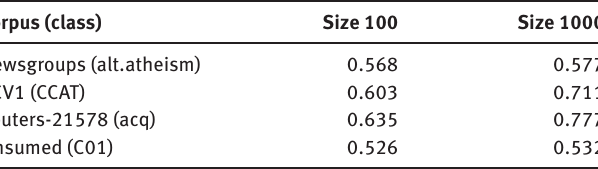
Table 4: Actual δ Values that were Learned with Empirical Bayes when Using Labeled Training Data of Size 100 and 1000, Respectively, Together with all Unlabeled